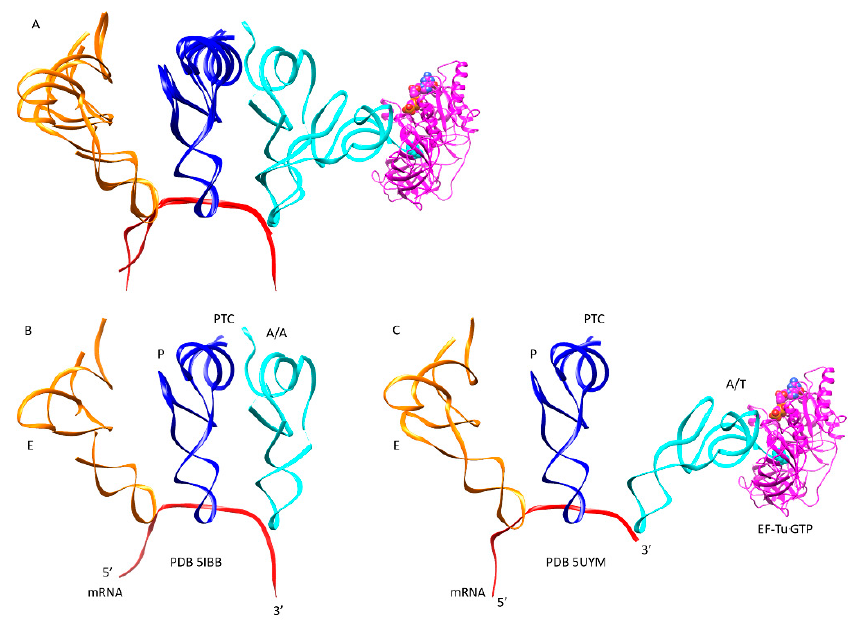
Figure 7. Accommodation of aa-tRNA from the A/T-site to the A/A-site. This is a multi-step process that includes elbow accommodation and CCA accommodation (see Figure 3; Table 1); ( A ) overlay of PDB 5IBB (A/A state) and 5UYM (A/T state); ( B ) the fully accommodated A/A state poised for peptidyl bond formation; ( C ) the A/T state before elbow accommodation and CCA accommodation. EF-Tu · GTP is colored magenta.